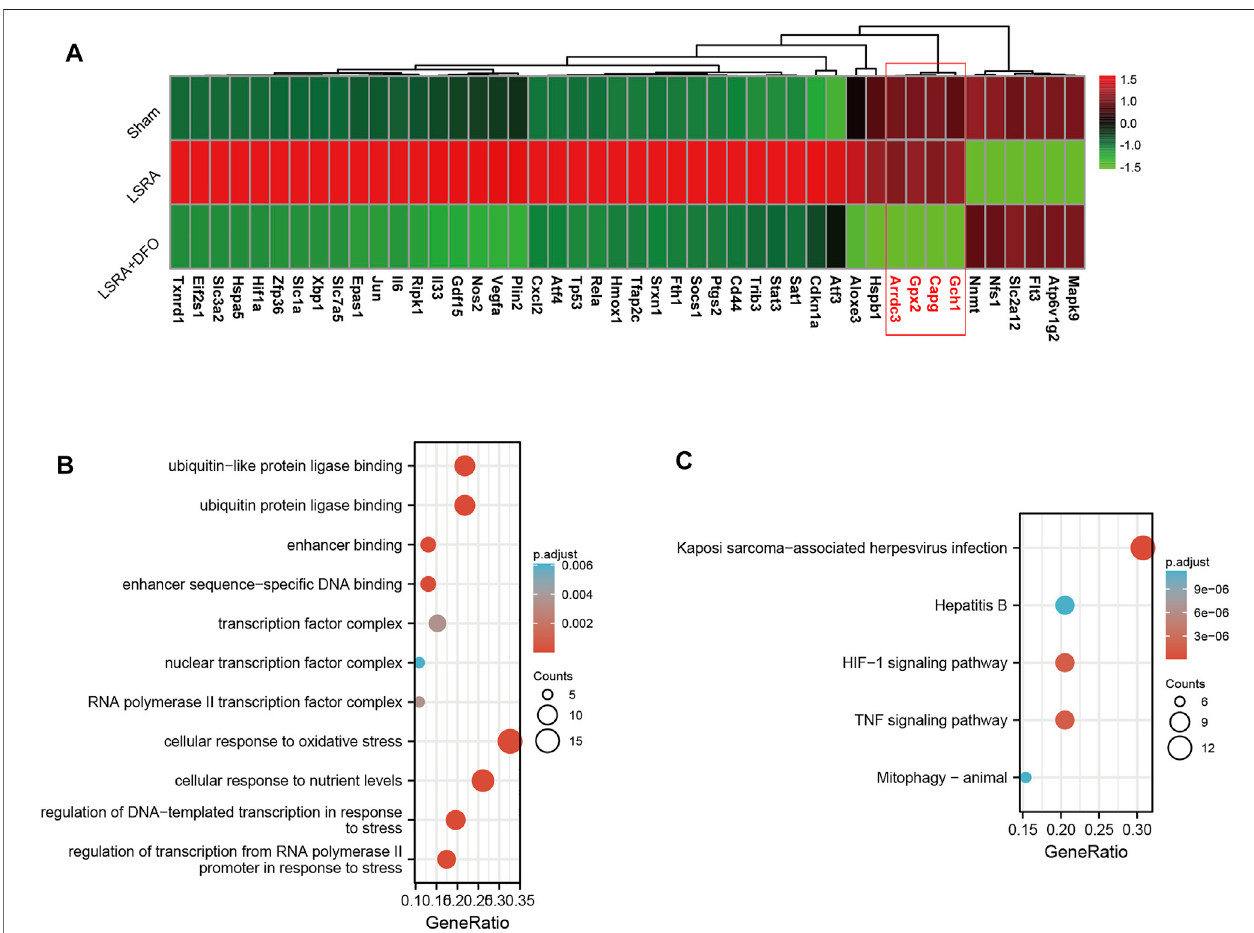
FIGURE3| FunctionalanalysesofferroptosisDEGsusingDAVID6.8. (A) TheheatmapshowingqRT-PCRanalysisresultsof46ferroptosisDEGs,andover90%of the ferroptosis DEGs (except four genes: Gch1, capg, Gpx2, and Arrdc3) were con fi rmed to be differentially expressed following LSRA, which can also be eliminated by the DFO treatment. n = 10 rats/group; signi fi cance was calculated using the one-way ANOVA with Tukey ’ s posthoc test, * p < 0.05. GO (B) and KEGG pathway (C) enrichment analyses of ferroptosis DEGs in the spinal cord after LSRA. Size and color indicate the number of enriched genes and the degree of enrichment, respectively.Abbreviations:DEGs,differentiallyexpressedgenes;LSRA,lumbosacralspinalrootavulsion;GO,geneontology;andKEGG, Kyotoencyclopediaofgenes and genomes.